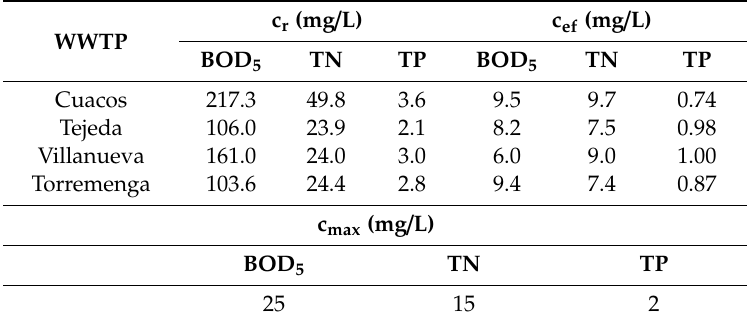
Table 3. Average monthly a ffl uent and e ffl uent concentration of four WWTPs. BOD 5 , biochemical oxygen demand at five days; TN, total nitrogen; TP total